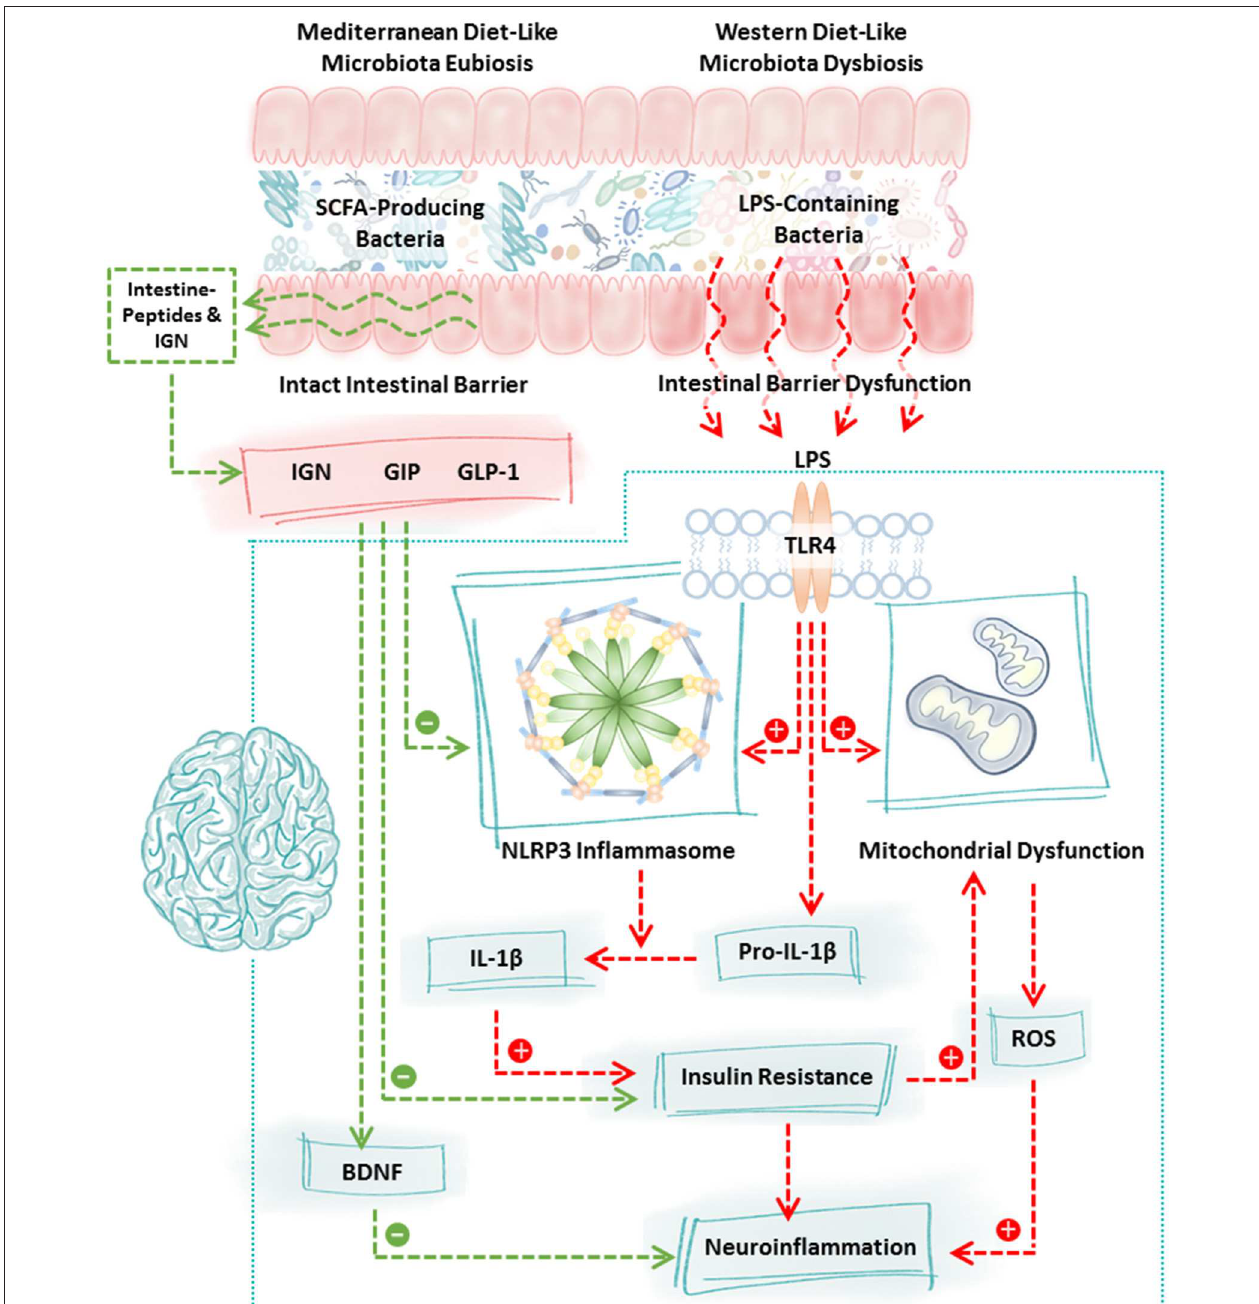
FIGURE 1 | Mechanisms of communication between the intestinal microbiota and the brain. Diet robustly impacts the intestinal microbiota. Consumption of a Western diet (or components of the Western diet) promotes the growth of LPS-containing bacteria and reduces the abundance of SCFA-producing bacteria whereas consumption of a Mediterranean diet (or components of the Mediterranean diet) promotes the growth of SCFA-producing bacteria and reduces LPS-containing bacteria. This shift is highly significant because LPS-containing bacteria are pro-inflammatory, they disrupt intestinal barrier integrity and LPS binding to TLR4 stimulates a cascade of events including NLRP3 inflammasome activation, mitochondrial dysfunction, and insulin resistance culminating in neuroinflammation and neurodegeneration. In contrast, increased production of SCFA due to consumption of the Mediterranean diet (or components of the Mediterranean diet) fortifies the intestinal barrier, stimulates the intestinal L-cell production of GLP-1 and GIP which inhibits NLRP3 inflammasome activation and normalizes insulin resistance. SCFA also stimulate intestinal epithelial cell IGN and together with GLP-1/GIP stimulate the vagus nerve and brain BDNF which has numerous beneficial effects on the brain and which improves neuron insulin resistance all of which function to promote neuronal health. Characteristic features of the PD microbiome are similar to those